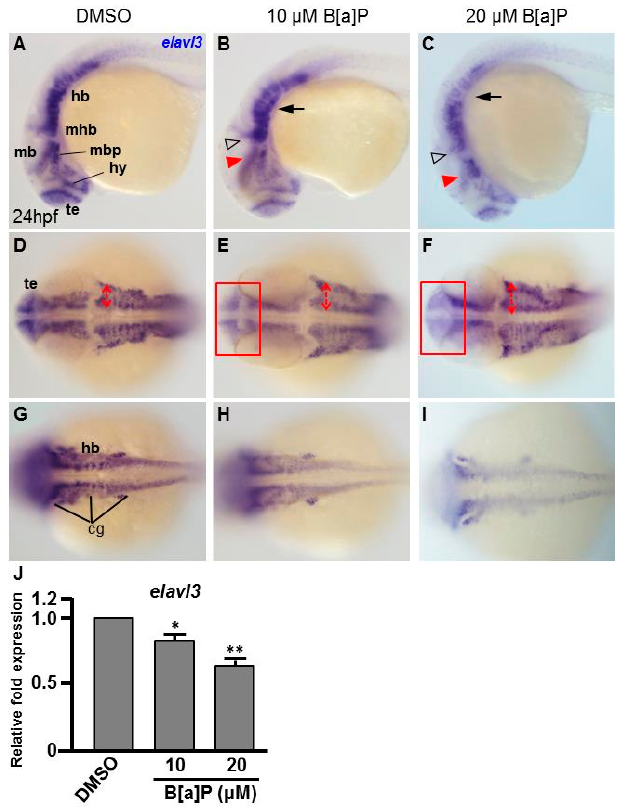
Figure 2. B[a] P- treated embryos exhibit defective nervous system development. In situ hybridization staining was performed with a riboprobe against elavl3 , a marker gene specifically expressed in telencephalon (te), hypothalamus (hy), midbrain (mb), midbrain hindbrain boundary (mhb) and plate (mhp) and hindbrain (hb) of the developing brain ( A ). ( A – I ) Zebrafish embryos exposed to 0 µ M. (control, 01% DMSO), 10- µ M B[a]P and 20- µ M B[a]P were analyzed at 24 hpf. Embryos in ( A–C ) are shown from the lateral view; the red arrowheads indicate developmental defects in the midbrain (mb), and the hollow arrowheads indicate developmental defects in midbrain-hindbrain boundary (mhb); ( D – F ) Embryos are shown from the lateral view. The developing telencephalon (te; rectangles in ( E , F )) was wider and the expression of elavl3 was weaker than in the control embryos; ( G – I ) Images are focused on the hindbrain (hb) region. The development of cranial ganglia (cg) was dose-dependently affected by B[a]P treatment; ( J ) Expression alteration of elavl3 i n B[a]P was quantified by real-time quantitative RT–PCR (* p < 0.05, ** p < 0.01 compared with the control).